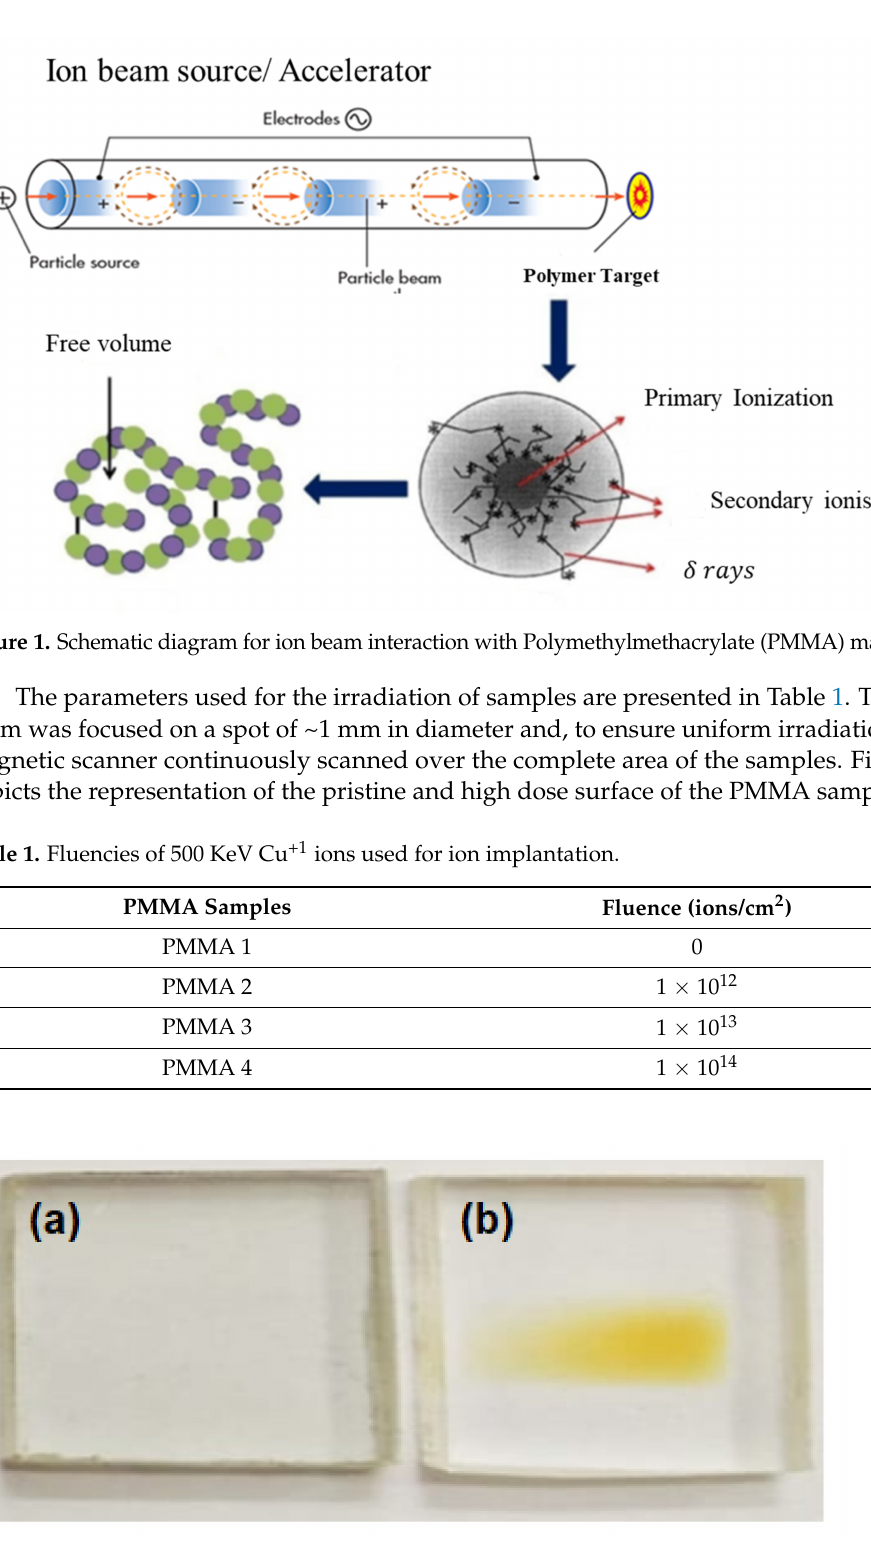
Figure 2. ( a ) Pristine and ( b ) Cu-implanted PMMA sheets with maximum dose of 1 × 10 14 ions/cm 2 . To avoid the channeling effect, implantation was performed at a low angle with respect to the ion beam direction. The electronic energy loss (S e ) and nuclear energy loss (S n ) for PMMA samples was calculated using the Stopping and Range of Ions in Matter (SRIM) simulation program